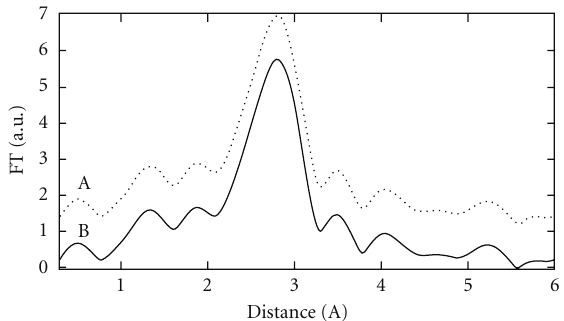
Figure 3: Band-gap calculated from the DR-UV-vis spectra Ti- HMS, img-Au/Ti-HMS and PAD-Au/Ti-HMS.